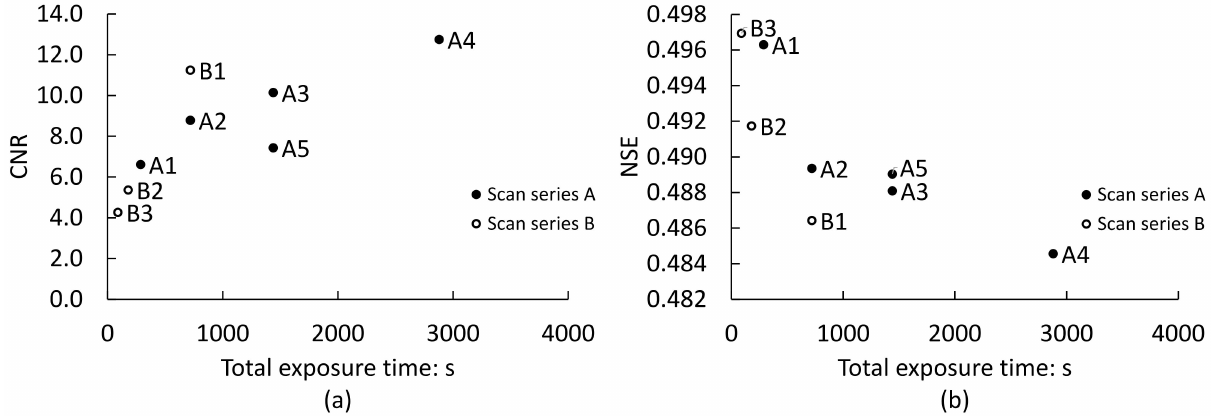
Figure 9. Image quality metrics for the central slice of the bottom (contacting) subvolume: ( a ) contrast- to-noise ratio, CNR (a higher value indicates better image quality); ( b ) normalised Shannon entropy, NSE (a lower value indicates better image quality). See Appendix A for calculation